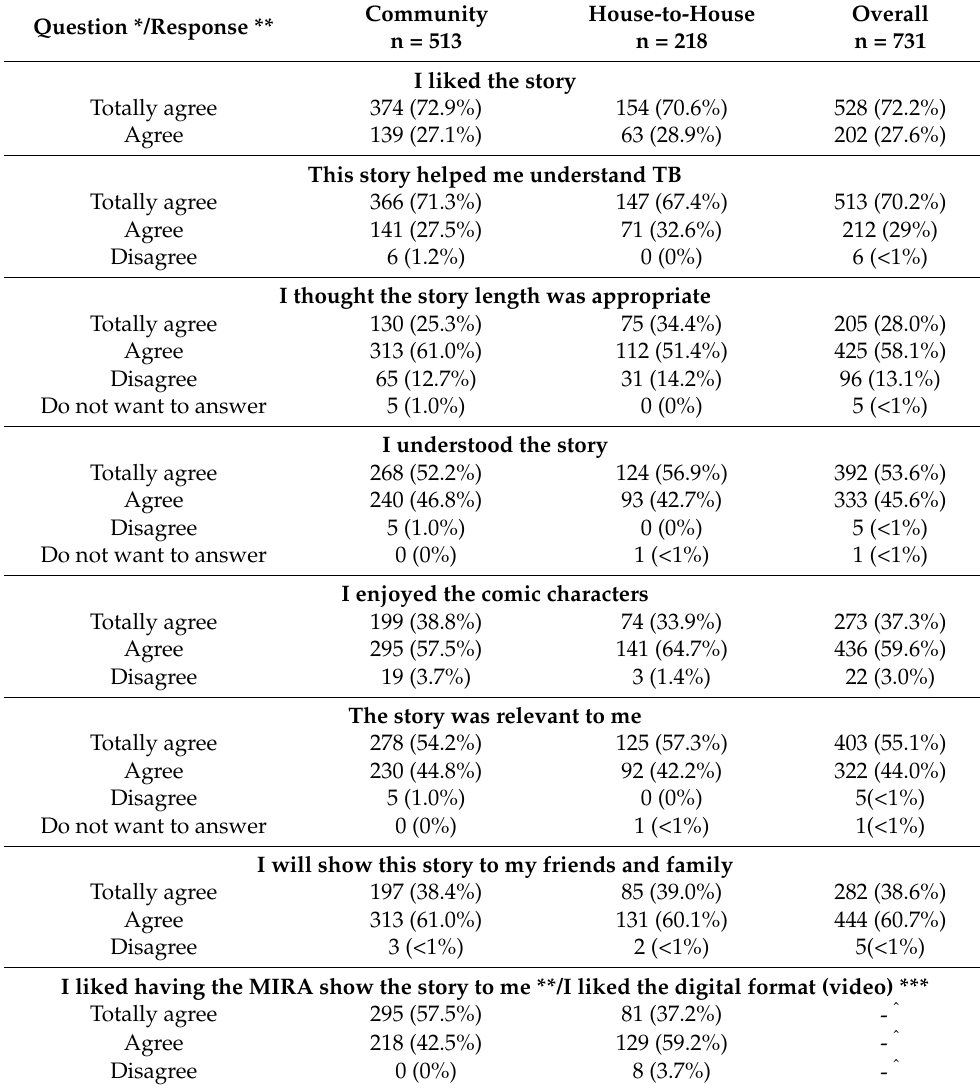
Table 2. Satisfaction with TB stories by intervention